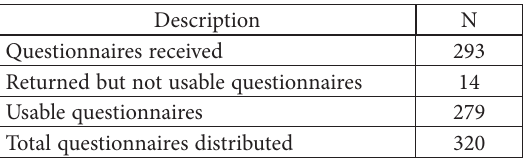
Table 1. Rate of response in main survey N = 279